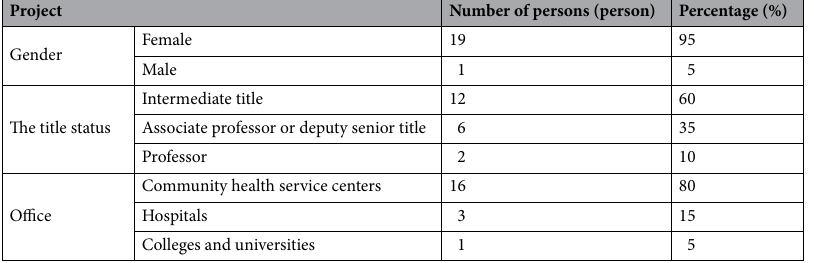
Table 1. Basic information of consulting